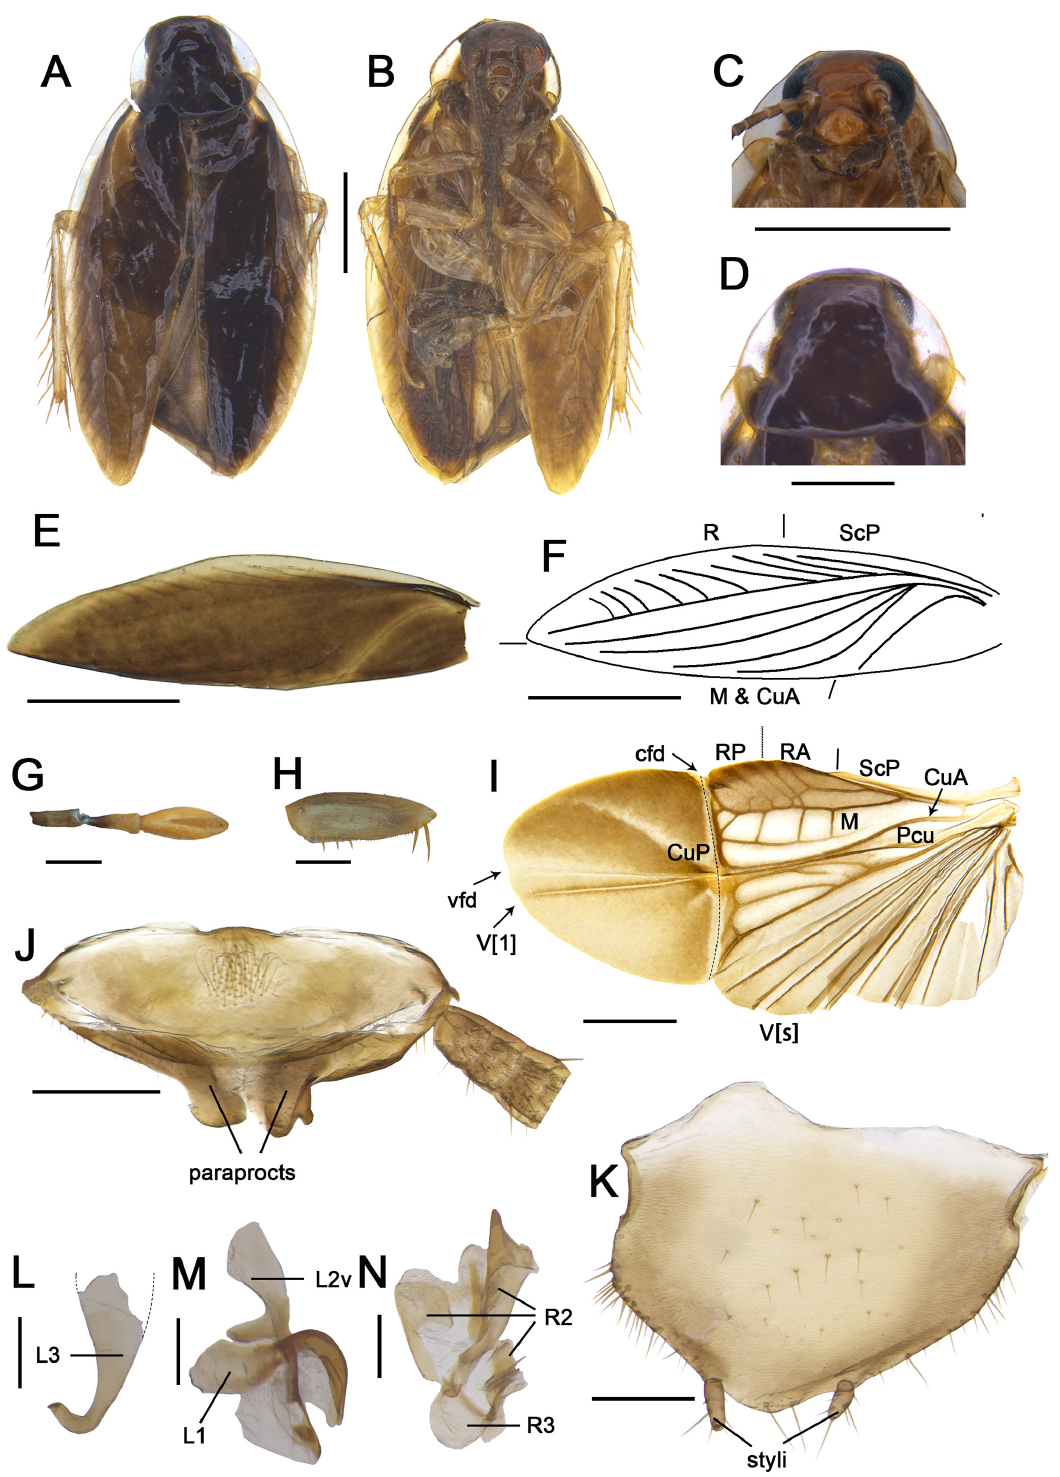
Fig. 7. Anaplecta cruciata Deng & Che sp. nov., holotype, ♂ (SWU). A . Habitus, dorsal view. B . Habitus, ventral view. C . Head, ventral view. D . Pronotum, dorsal view. E . Tegmina. F . Tegmina vein. G . Maxillary palp. H . Front femur, ventral view. I . Wings. J . Supra-anal plate, dorsal view. K . Subgenital plate, ventral view. L . Hook, ventral view. M . Left phallomere, ventral view. N . Right phallomere, ventral view. Scale bars: A–C = 1 mm; D–F, I–K = 0.5 mm; G–H = 0.2 mm; L–N = 0.25